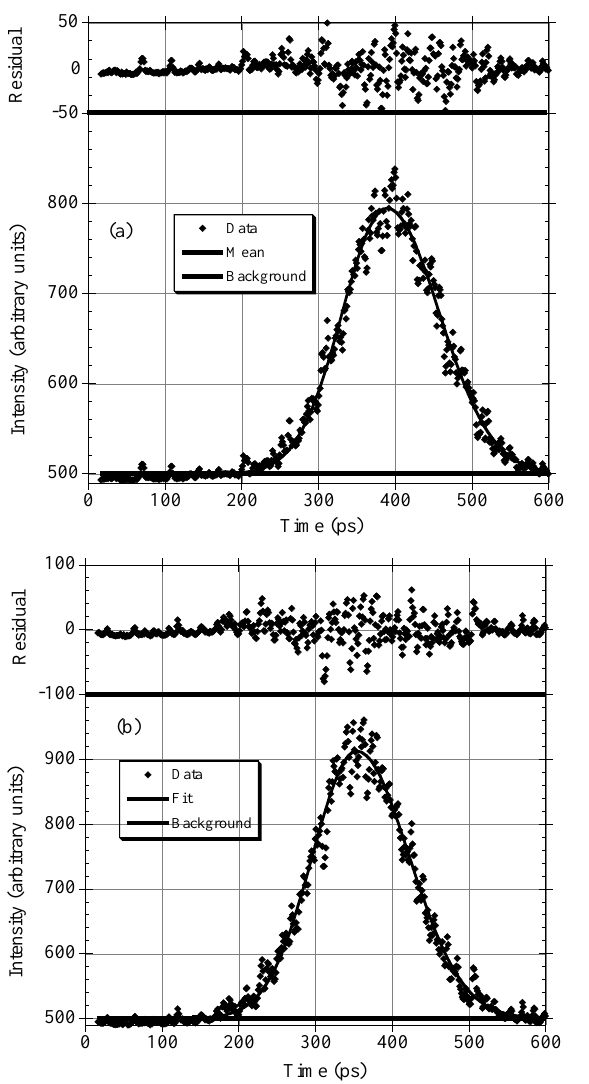
FIG. 22. A single data acquisition of the electron longitudi- nal bunch distribution measured by the streak camera when (a) the longitudinal feedback is off and the longitudinal insta- bility is present and (b) the longitudinal feedback is on and the longitudinal instability is not present. The residual when the instability was present (c) and not present (d).